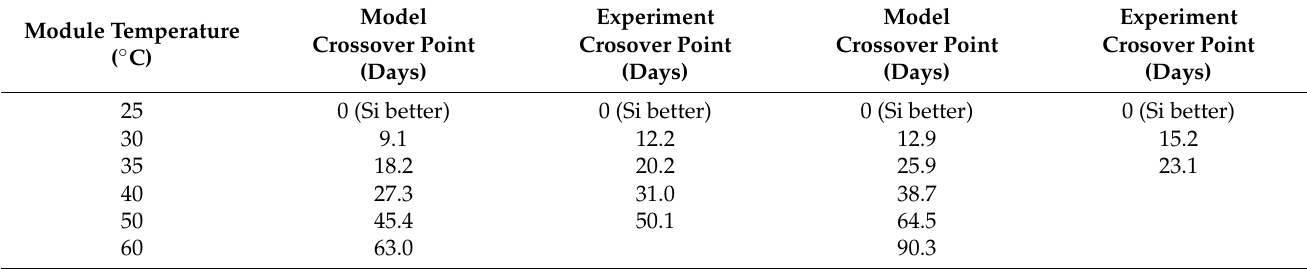
Table 2. Comparison of predicted (model) crossover points (days of soiling) with experimental data crossover points. The experimental crossovers are determined from the fitted data. The crossover is the point in the soiling duration time (days) at which the Si module starts to have a better normalized Pmax (better performance) than the CdTe or a-Si:H modules because of spectral effects at that particular module temperature. The experimental data show the general trends predicted by the model. At 25 °C, the Si module performs better than either other technology because of the increased absorption by the soiling layer in the low-wavelength region that affects CdTe and a-Si:H more than Si.